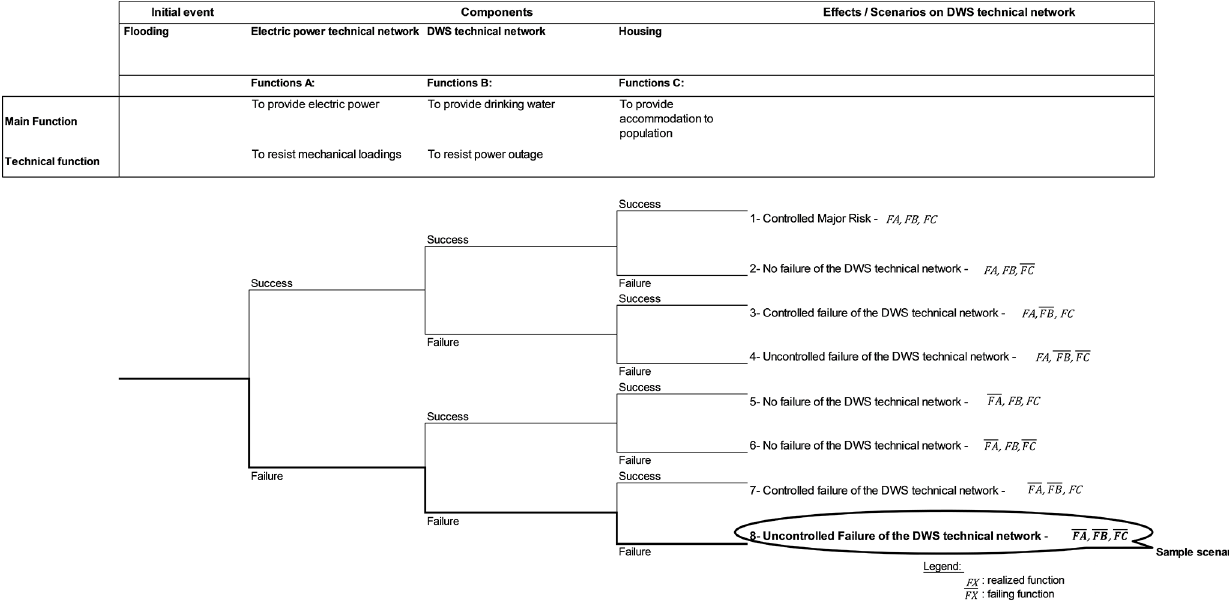
Figure 3. Sample of ETM: application to drinking water supply technical network.